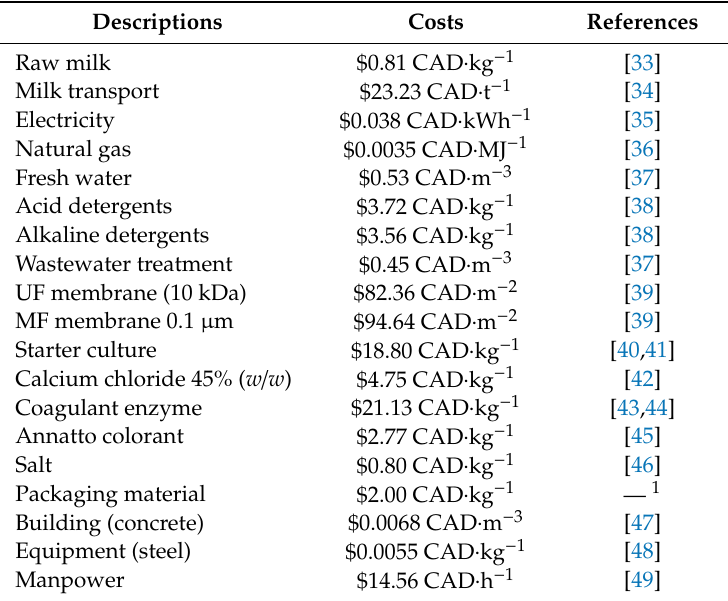
Table 1. List of the costs considered in scenarios A, B, and